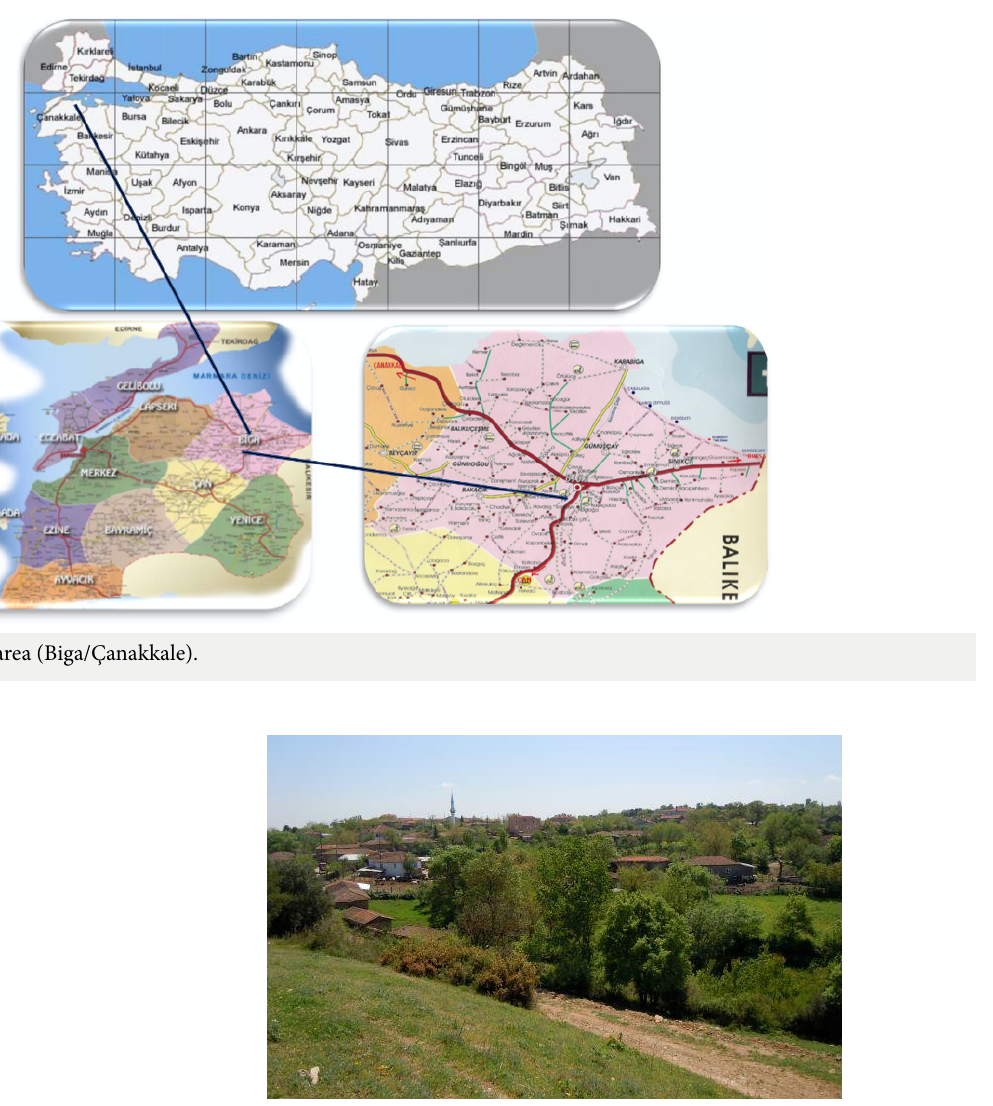
Figure 2 General view of a village in